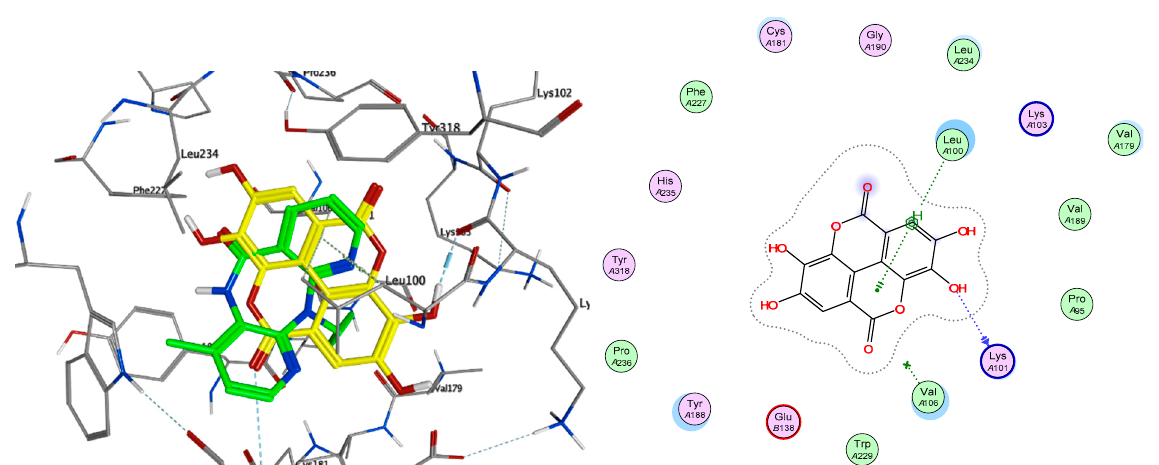
Figure 5. Overlay of ellagic acid 10b (yellow) with known inhibitor Nevirapine (green) in the non-nucleoside inhibitor binding pocket portion of reverse transcriptase RT (PDB ID 1JLB) ( left ) and ligand interactions of 10b with non-nucleoside inhibitor binding pocket of RT ( right ).